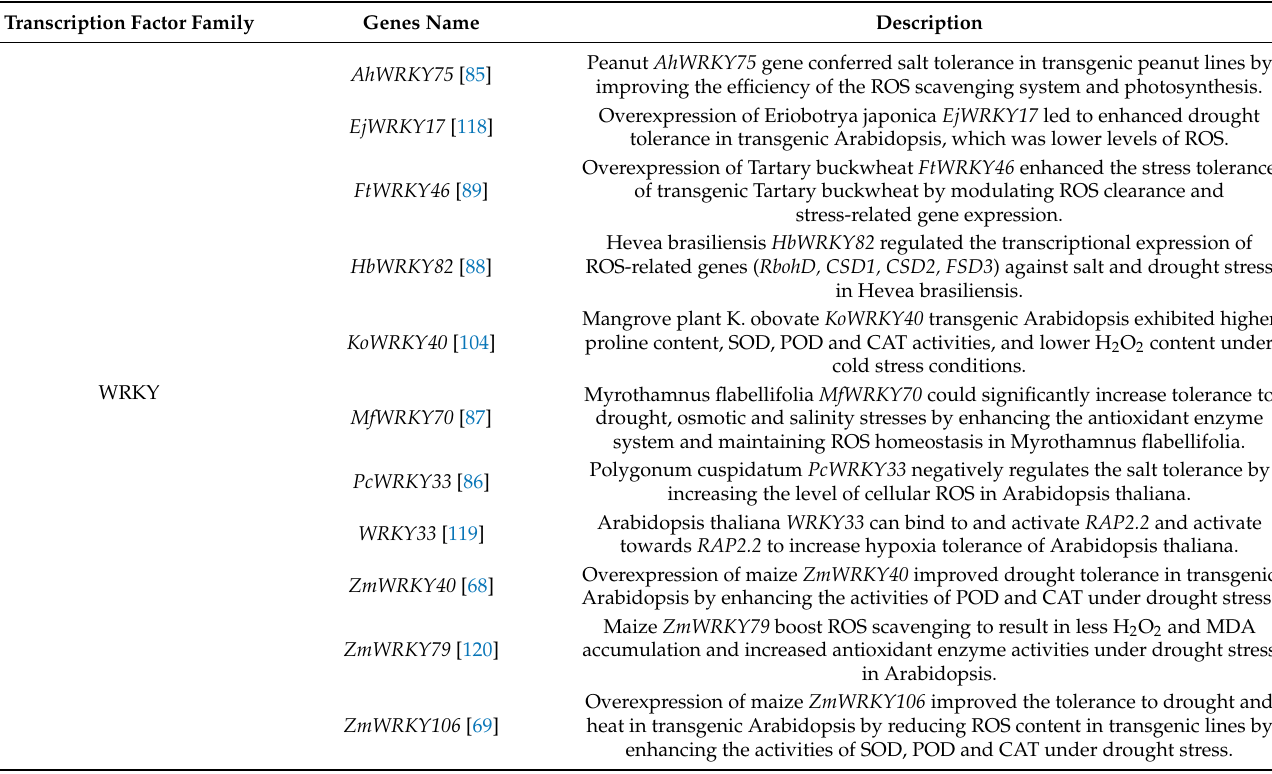
Table 1. Transcription factors that participate in the metabolism of